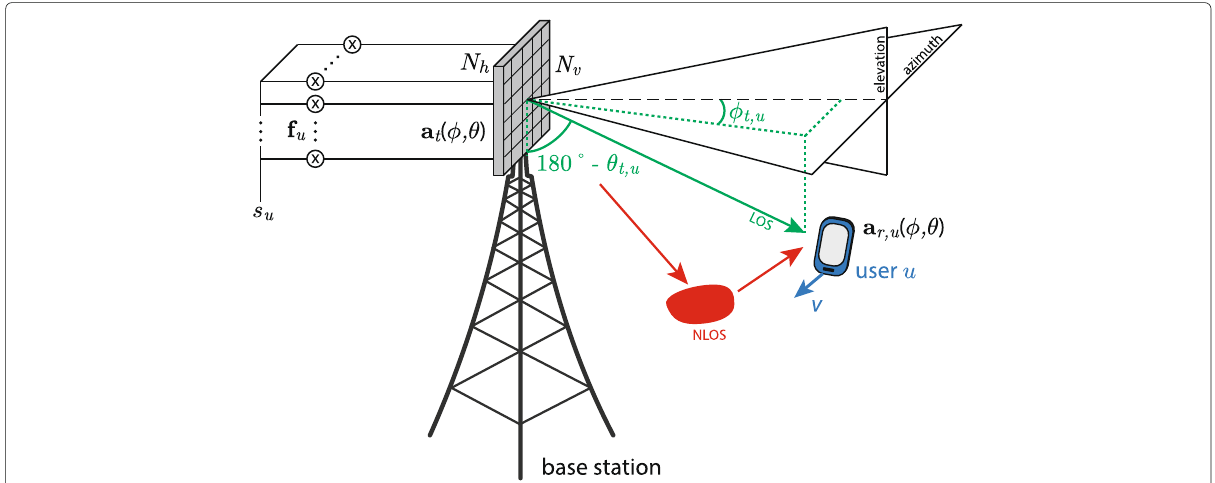
Fig. 1 Illustration of the considered FD-MIMO transmission system employing three-dimensional downlink